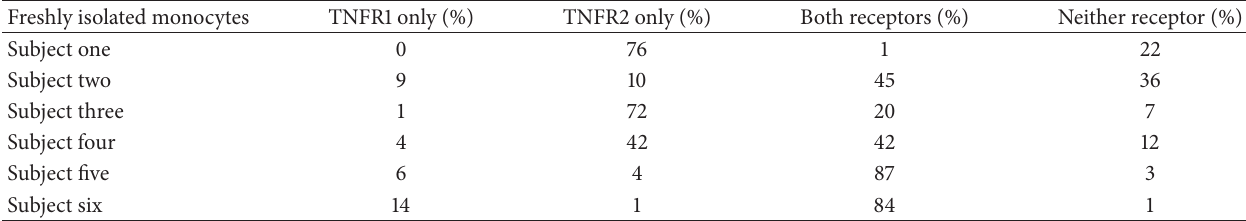
Table 3: Expression patterns of TNFR1 and TNFR2 on freshly isolated monocytes.